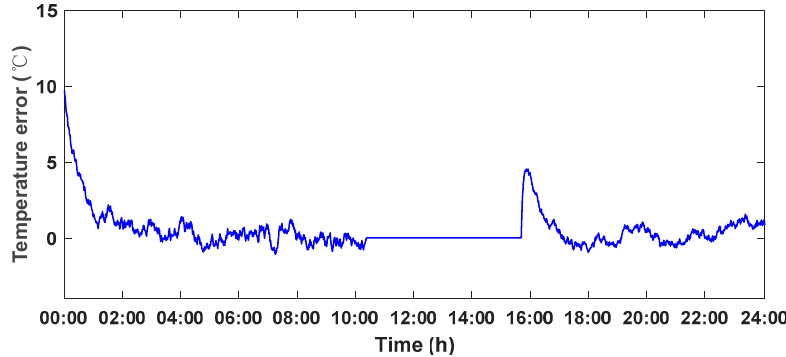
Figure 17. Variation errors of conventional PID control during the experimental process.